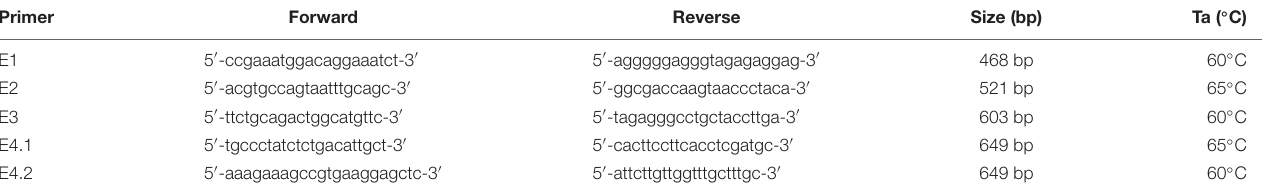
TABLE 1 | Primer sequences and PCR conditions for mutation screening of MECP2 gene. Primer Forward Reverse Size (bp)